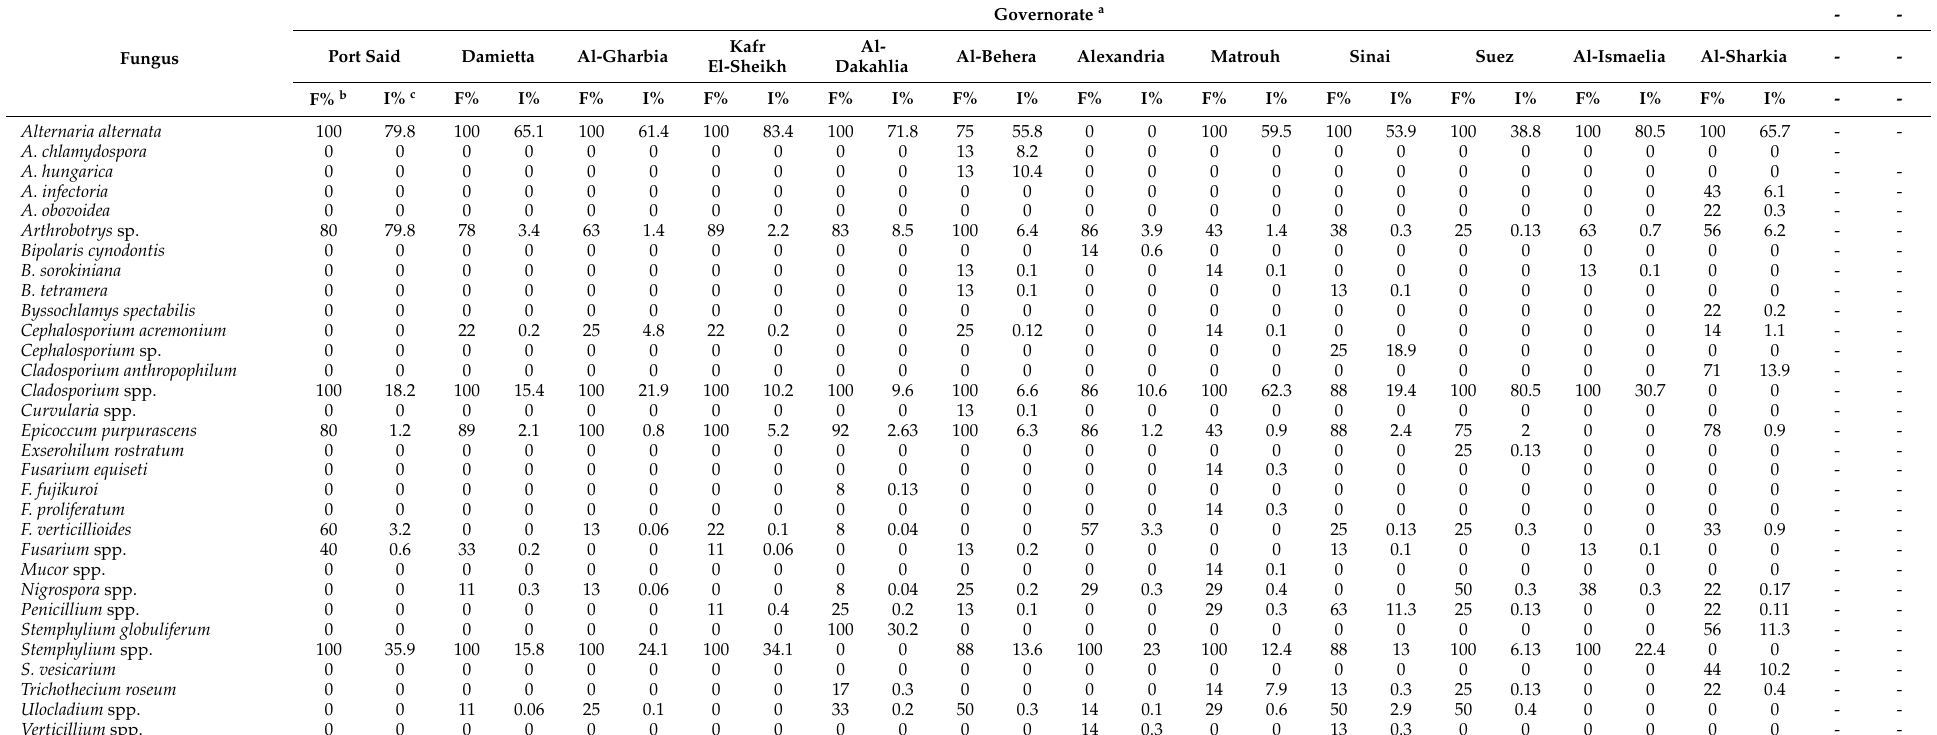
Table 1. Frequency (F) and average incidence (I) of 42 wheat seed-borne fungus species in each of the 25 wheat-growing governorates of Egypt a